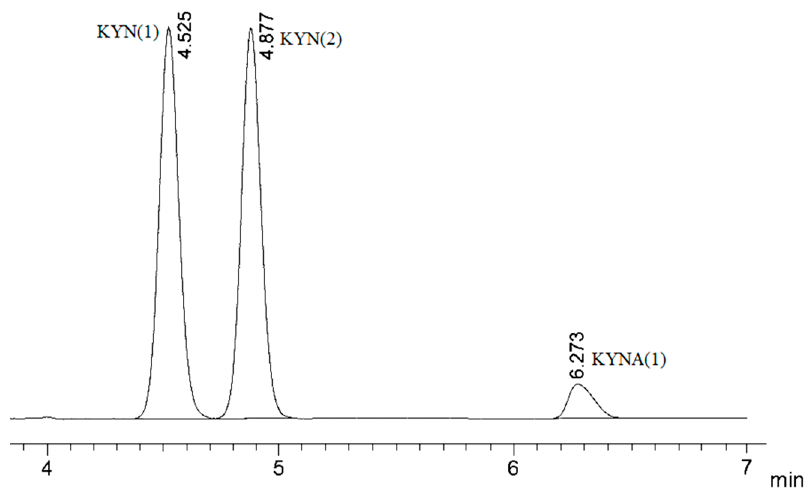
Figure 1. HPLC-based activity assay in which the mobile phase used was a water-acetonitrile (93:7) mixture and the detection wavelength was 330 nm. Injection (1) hKAT-II incubated with kynurenine (KYN), pyridoxal phosphate (PLP) and α -ketoglutarate in which kynurenic acid (KYNA) peak was observed; Injection (2) indicates the control that was missing hKAT-II in otherwise the same reaction mixture only has detected the KYN peak.